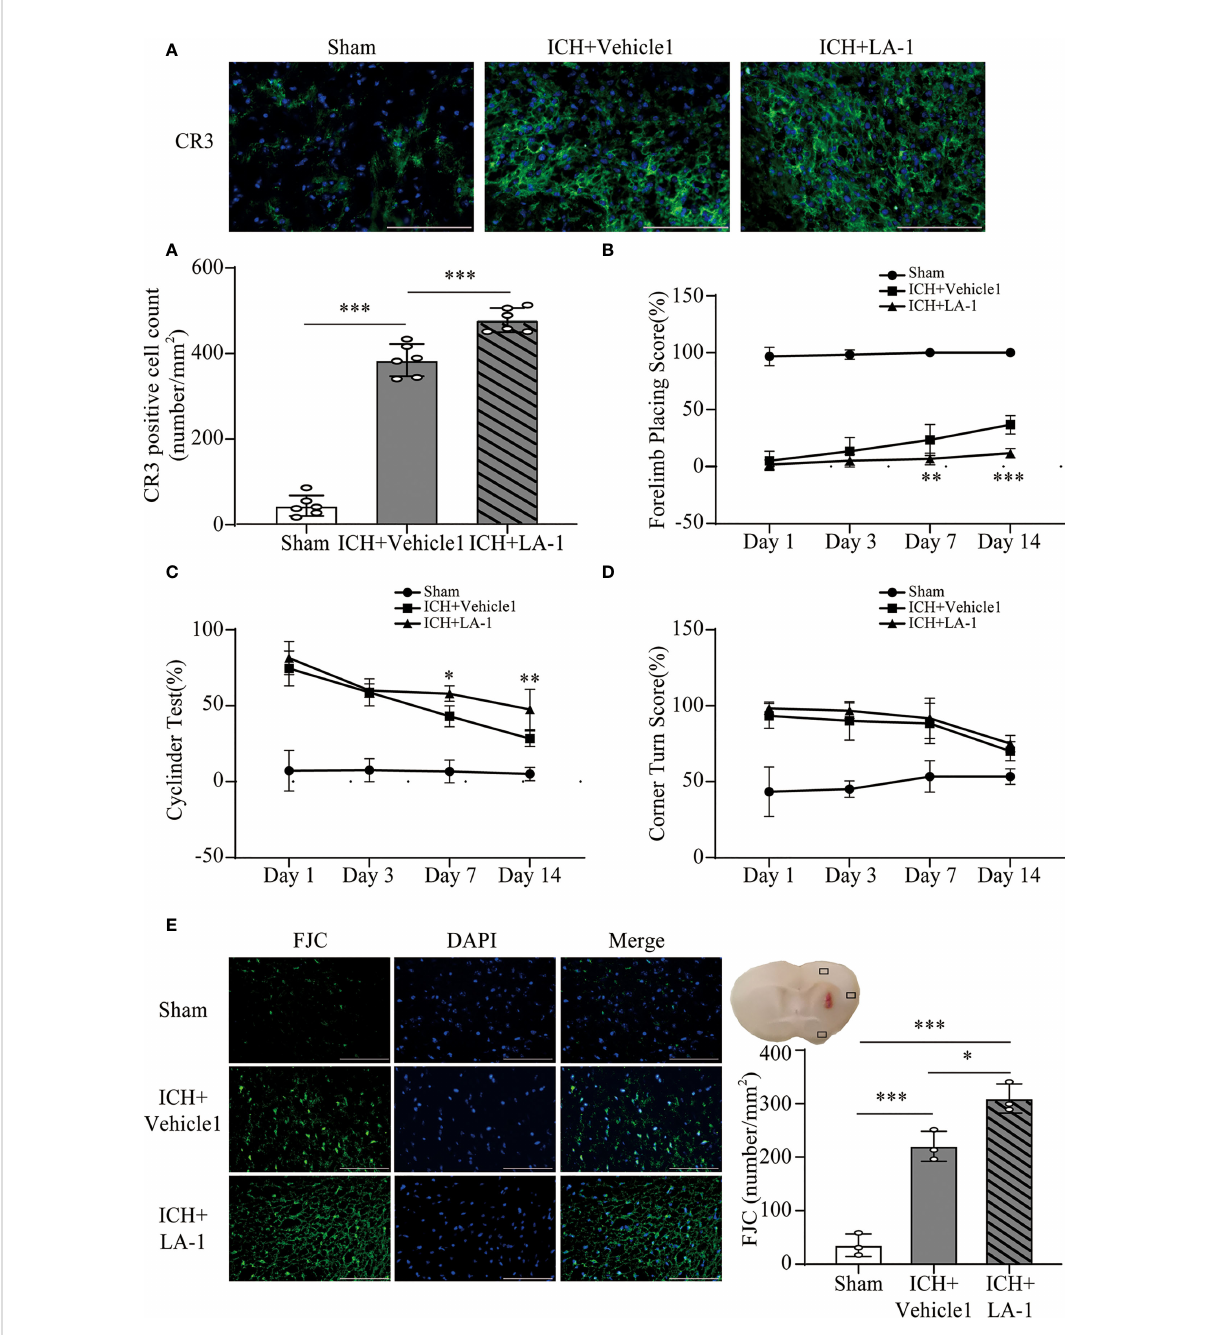
FIGURE 3 The effect of CR3 activation on brain damage after ICH. (A) Representative immuno fl uorescence images and quantitative analysis of CR3 positive cell. n = 6. ***P <0.001 by one-way ANOVA. (B – D) Quanti fi cation of neurological function in the forelimb placing test (B) , cylinder test (C) , and corner turn test (D) at days 1, 3, 7, and 14. n = 6. *P <0.05, **P <0.01 versus ICH+ vehicle1 group by two-way ANOVA. (E) Representative immuno fl uorescence images and quantitative analysis of FJC-positive cells in the ipsilateral cerebral cortex. n = 3. *P <0.05, **P <0.01, ***P <0.001 by one-way ANOVA. Scale bar = 100 m m. Data are represented as mean ±